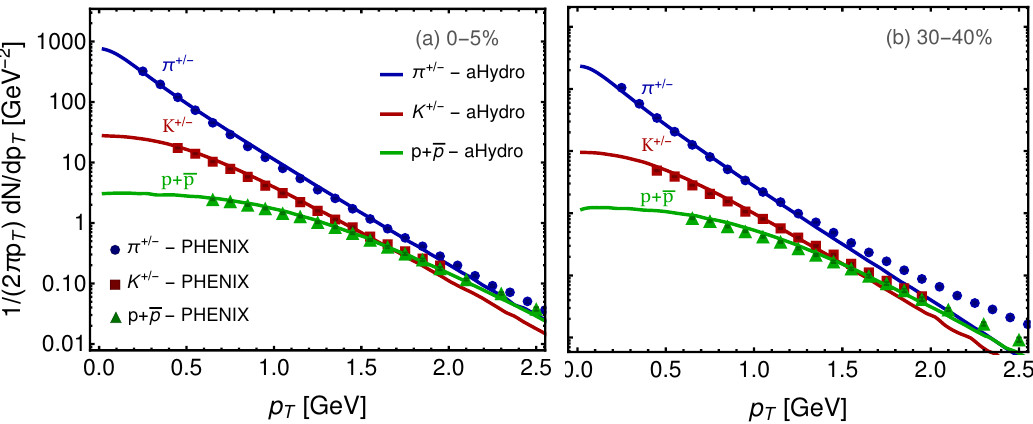
Figure 1. Pion, kaon, and proton spectra predicted by aHydroQP compared to experimental observations by the PHENIX collaboration [19]. The panels show the centrality classes ( a ) 0–5% and ( b )